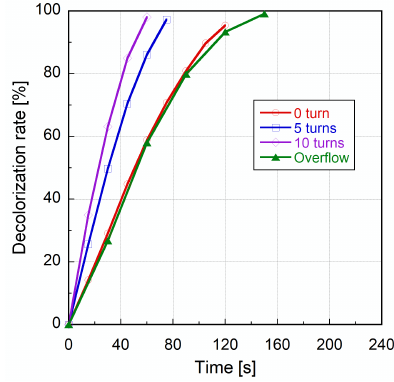
Figure 9. Decolorization rates of indigo carmine as a function of treatment time with various turns of the nylon wire (0.8 mm in diameter). Pulsed streamer discharges with the peak voltage and repetition frequency of 21 kV and 100 pps were irradiated to the 10 mg/L indigo carmine solution in the swirling-flow-type reactor. The solution was circulated with a flow rate of 1400